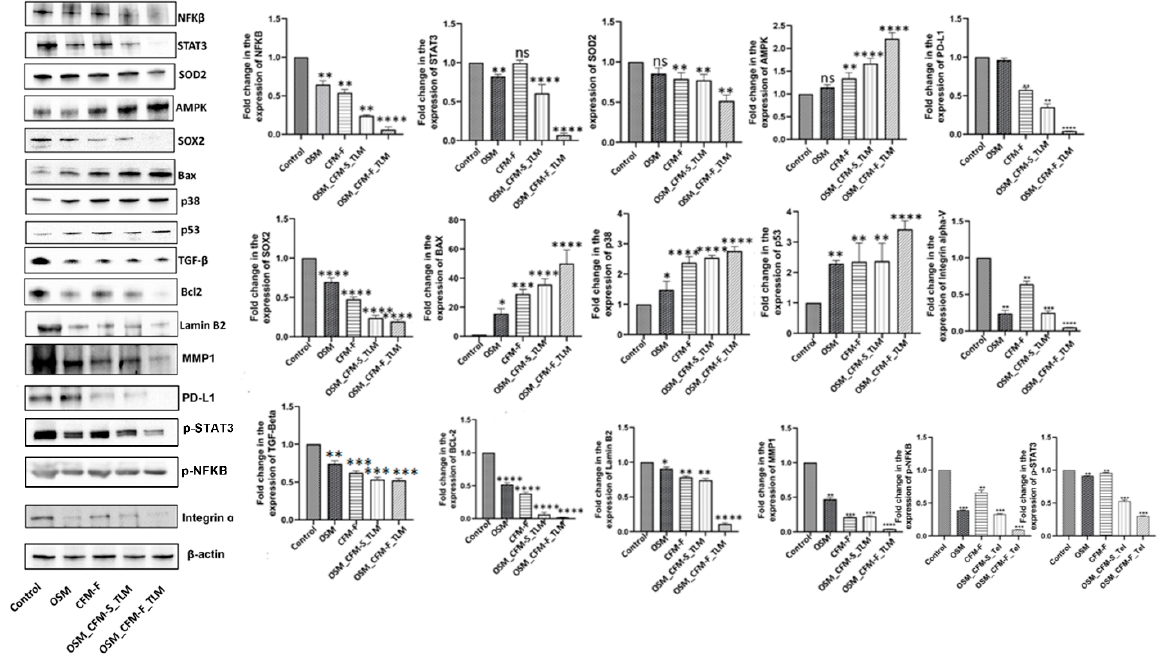
Figure 4. Western blot data analysis for the effect of Telmisartan, CFM-F, and Osimertinib and their combinations against H1975 lung cancer. Western blots and densitometric analysis of various proteins in the H1975 xenograft model of lung cancer. Data are representative of three different experiments and presented as mean, and error bars refer to SEM. ns p > 0.05 * p < 0.05, ** p < 0.01, *** p < 0.001, **** p < 0.0001 was considered significant when compared to the control.